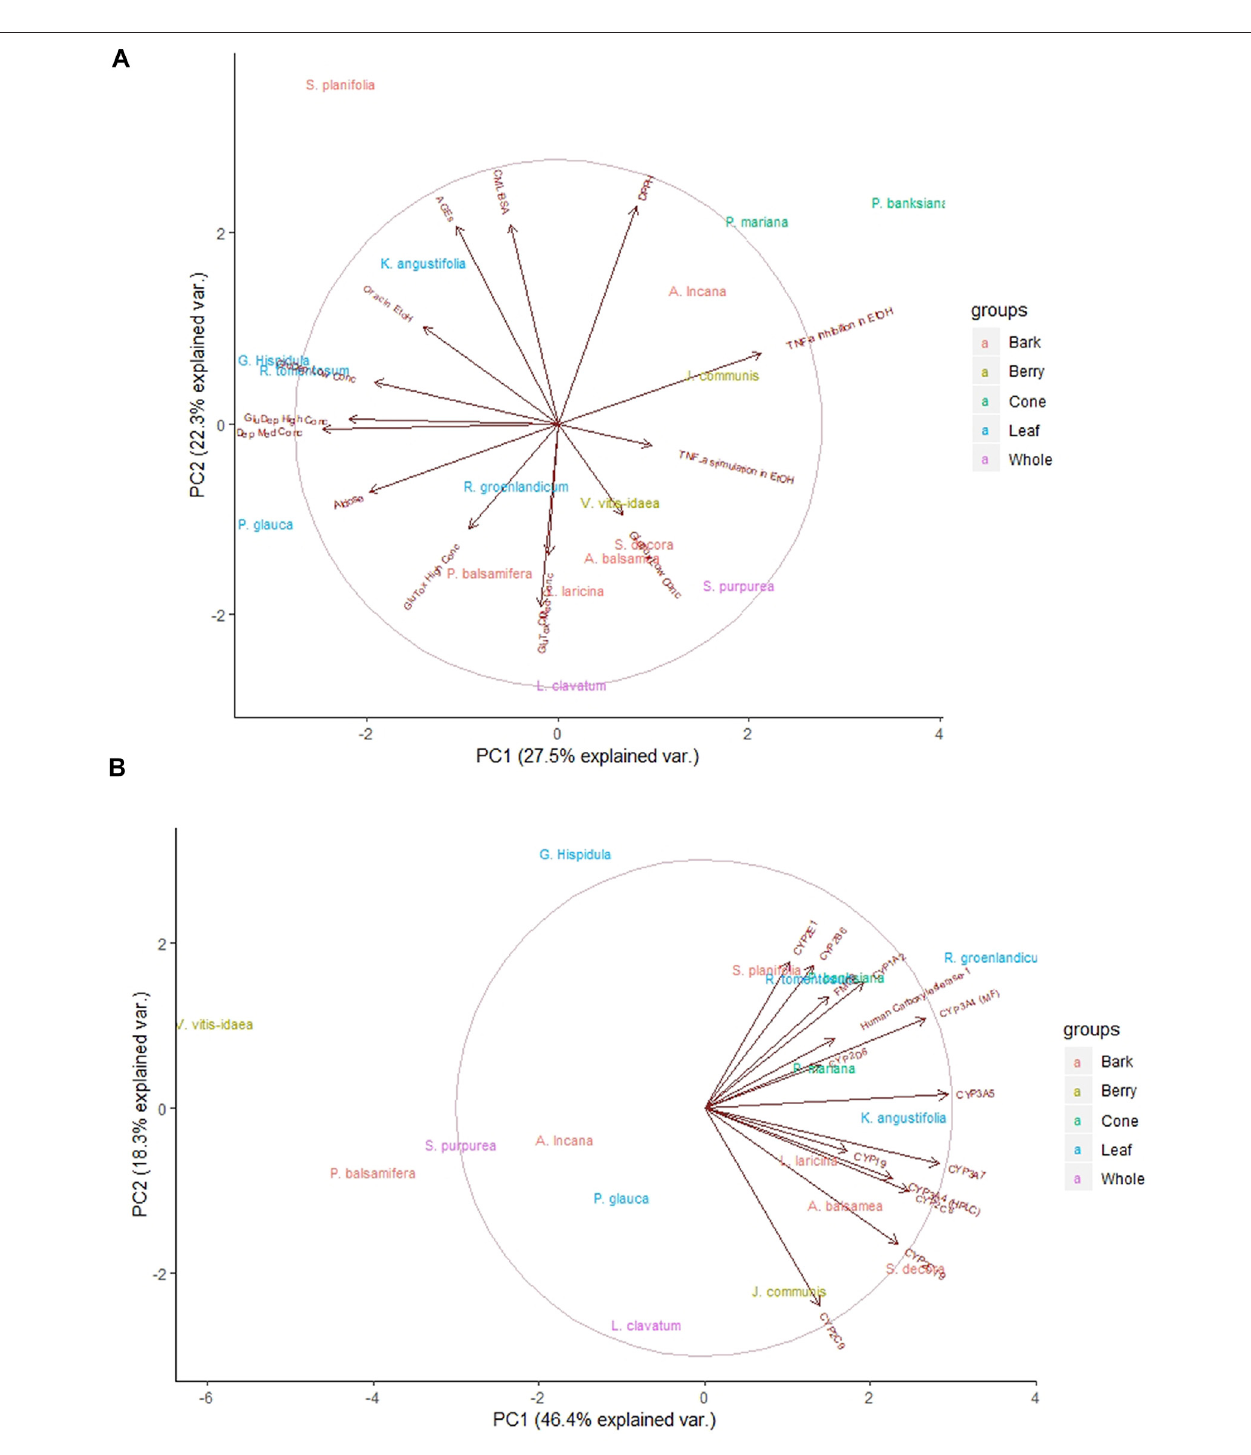
FIGURE 3 | Principal component analysis of Cree medicinal plant biological activity subgroups. Groupings re fl ect rankings based on plant part used. (A) Analysis using secondary anti-diabetic bioassays. (B) Analysis using herb-drug interaction bioassays. Central circles represent 95% con fi dence interval on full data sets. Ellipses indicate 95% con fi dence intervals on groupings.